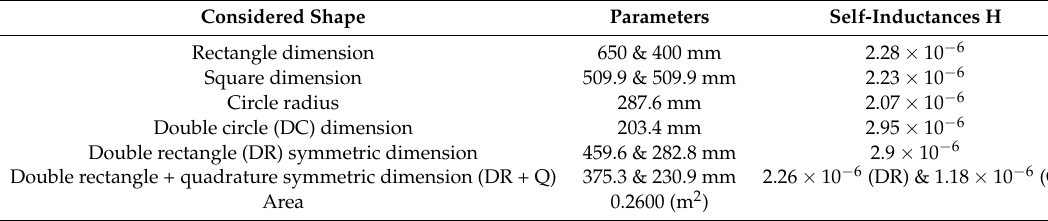
Table 2. Physical parameters of various coil shapes used in the air-cored